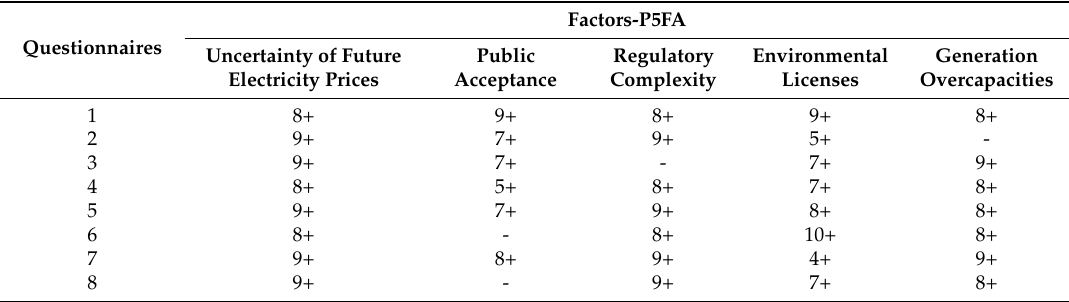
Table A1. Consistency check of the experts’ answers, Porters’ five forces analysis—interquartile range calculation (last line), empty cells (-) define no answers